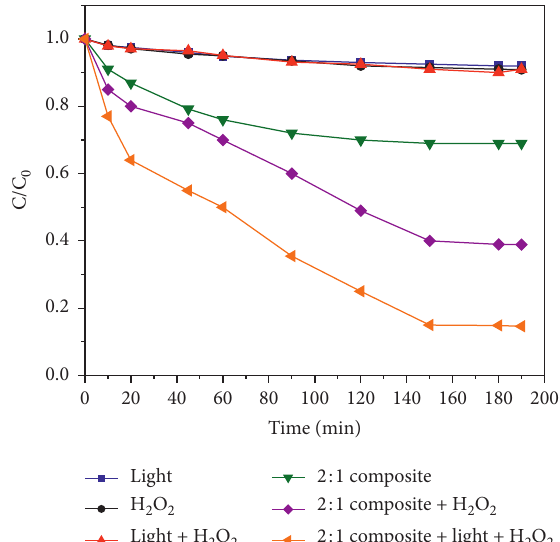
� 9.79 mM, and 2 O 2 ]